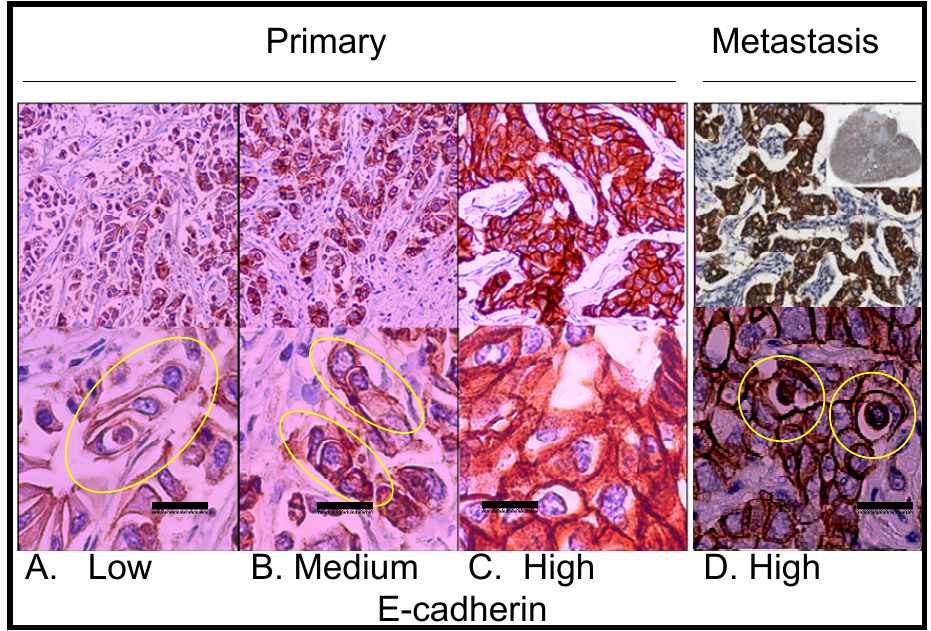
Figure 4. Immunohistochemical staining showing E-cadherin expression in the primary lesion and lymph node metastasis. ( A ) Primary lesion: region with low E-cadherin expression; the yellow ellipse indicates a multicell entotic figure. ( B ) Primary lesion: region with medium E-cadherin expression; the yellow ellipses indicate entotic figures. ( C ) Primary lesion: region with high E-cadherin expression; no visible entotic figures. ( D ) Lymph node metastasis; the upper right small insert: whole lymph node scan; strong and homogenous E-cadherin expression was observed within metastatic carcinoma cells; the yellow rings indicate entotic figures. Upper panel—10 × microscope objective; lower panel—40 × microscope objective. Scalebar 15 µ M.